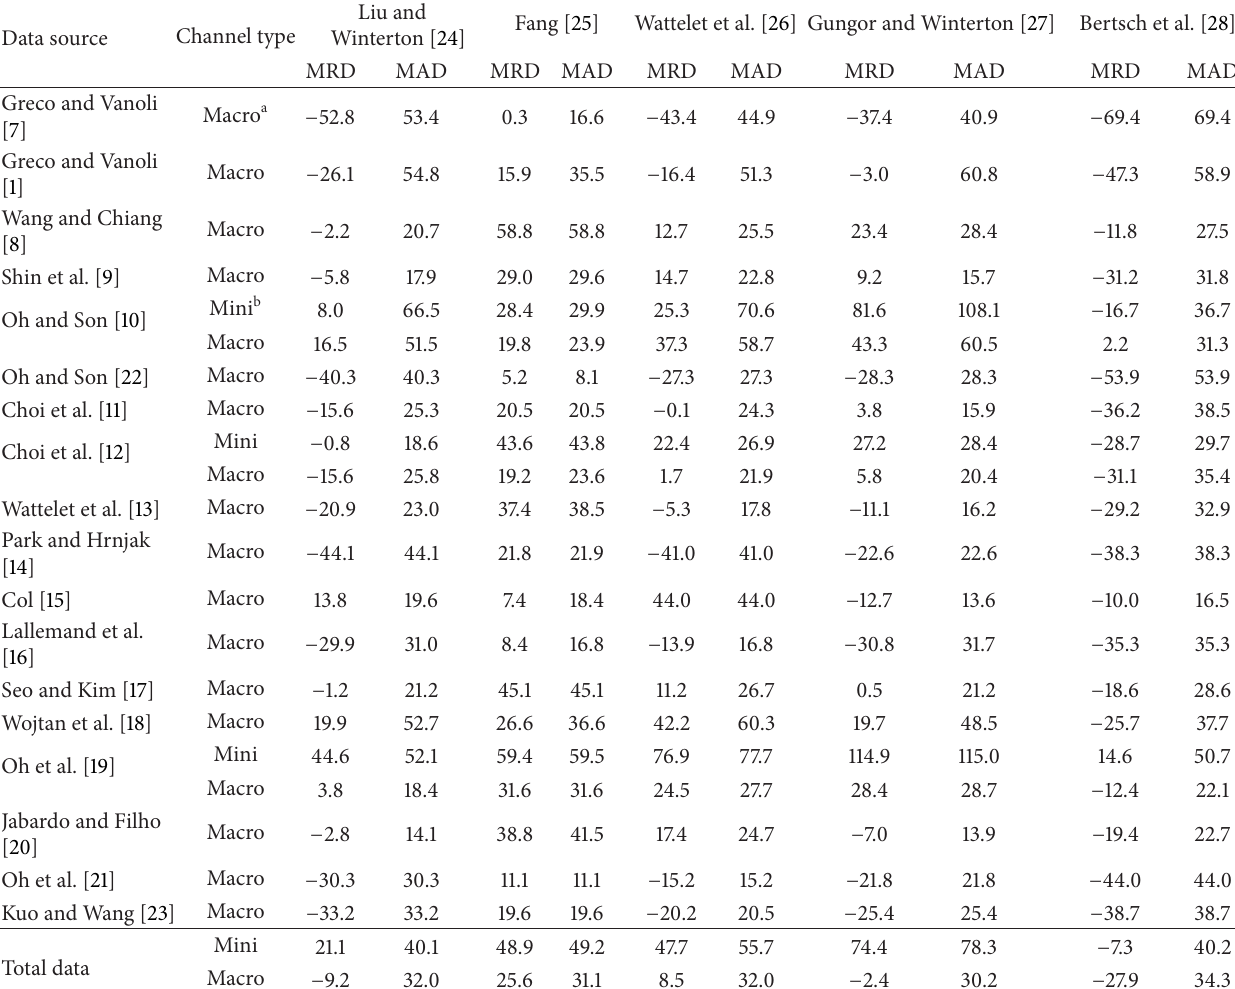
Table 3: Deviation of the top 5 correlations for different channel dimensions by Kandlikar and Grande method and by Kew and Cornwell method